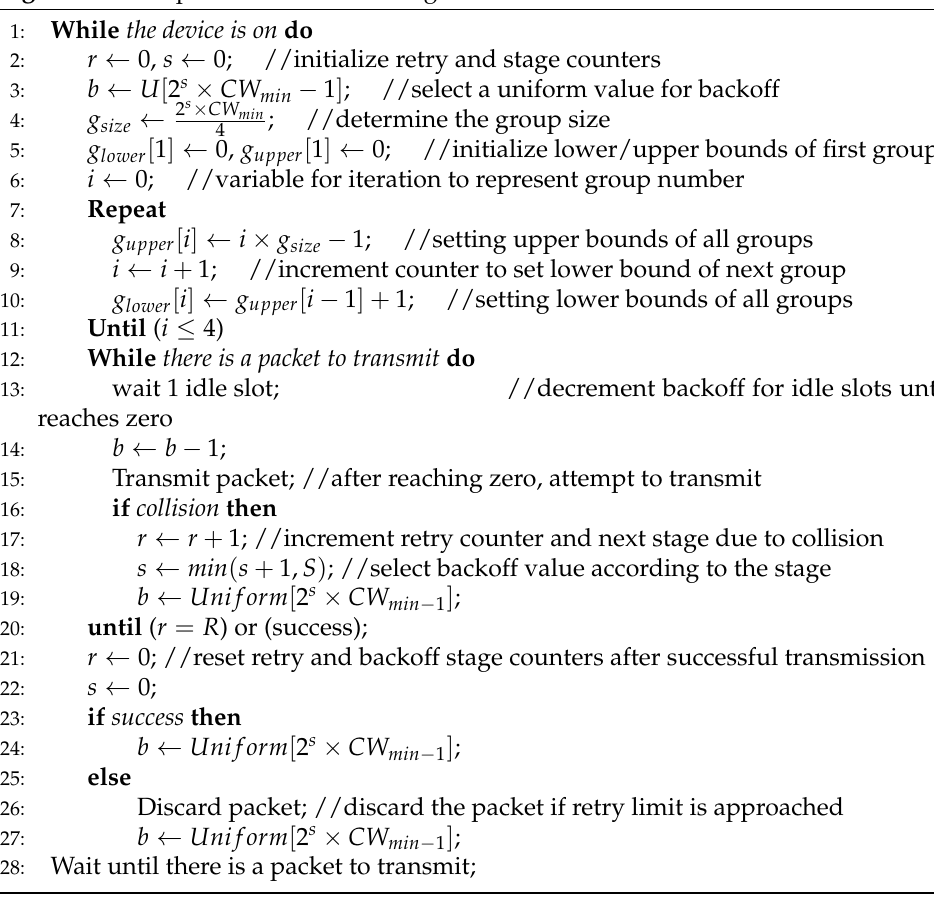
Algorithm 2 Proposed CSMA/RCA